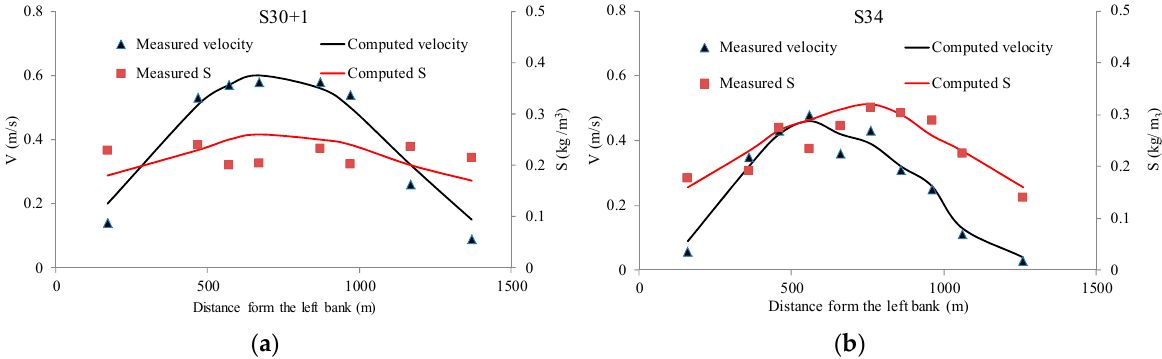
Figure 8. Simulated suspended load concentrations on typical cross-sections. ( a ) the discharge is 6300 m 3 /s and water level is 139 m; (b) the discharge is 32100 m 3 /s and water level is 135 m.